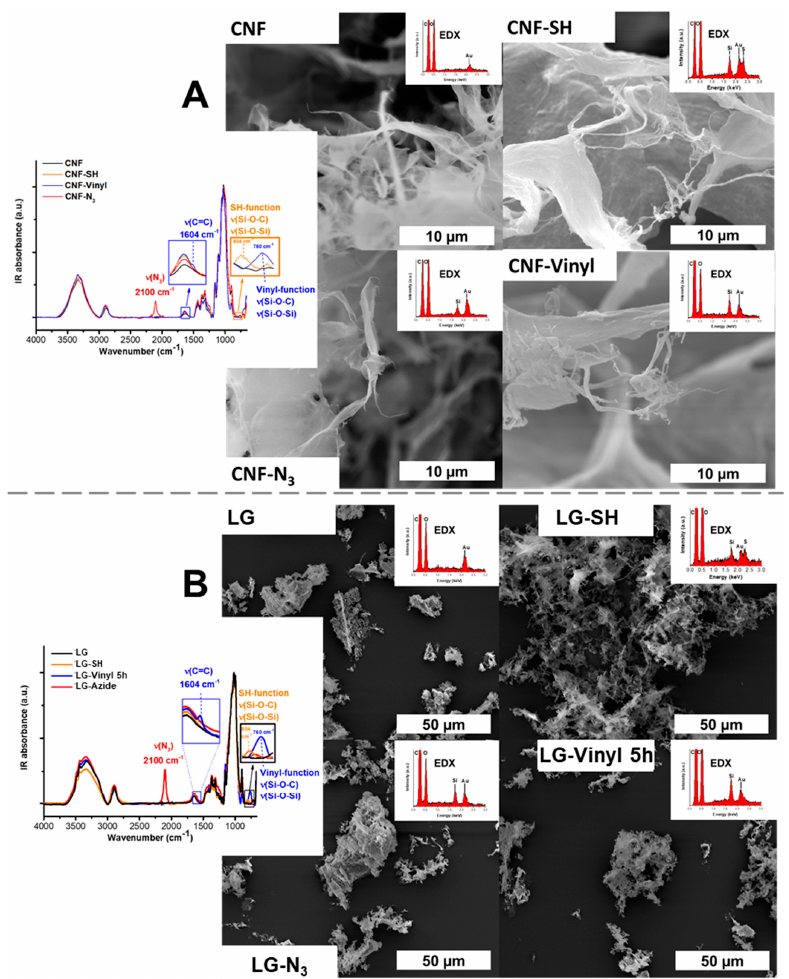
Figure 3. Silanization of cellulose nanofibrils ( A ) and cellulose II gel (LG, ( B )) using mercapto-, azido- and vinyl silane as shown by infrared (IR) spectroscopy and scanning electron microscopy with